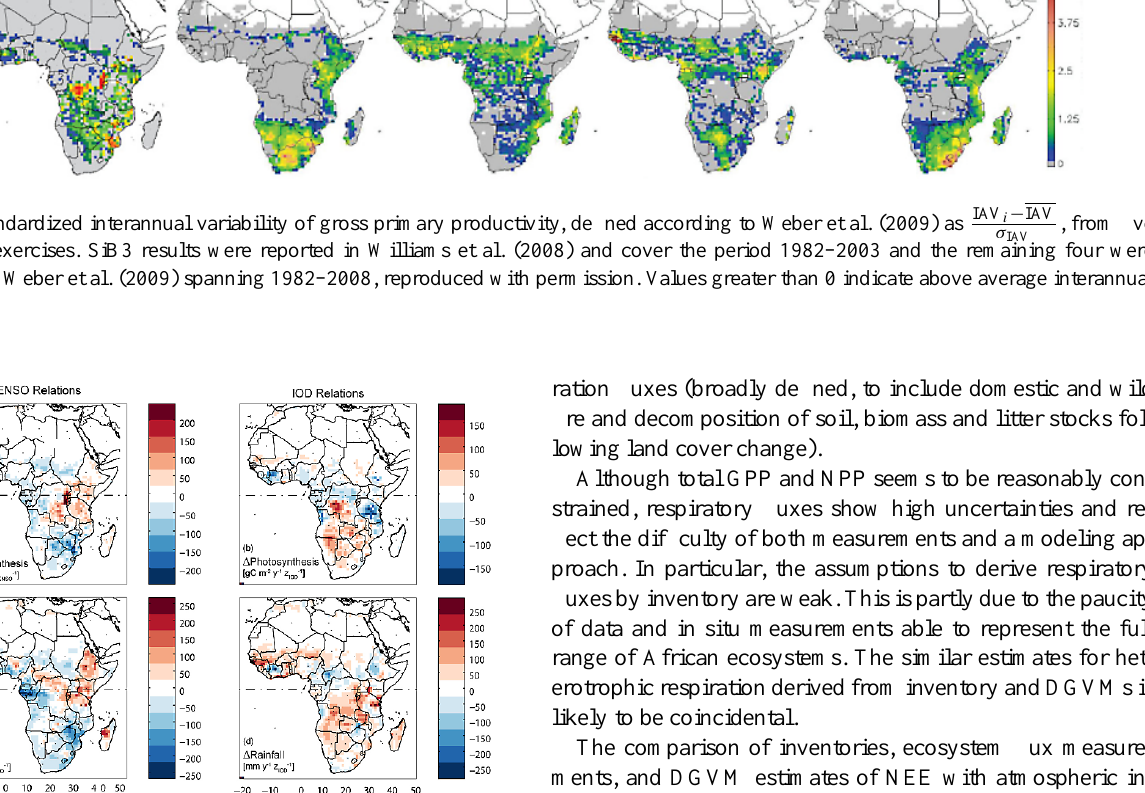
Fig. 7. Spatial distribution across Africa of the slope of least-squares linear regressions of SiB3 modeled (a, b) annual net photosynthe- sis ( P net ) or CRU/TRMM (c, d) annual rainfall on climate indices. Each column corresponds to analyses with a particular index with the left column (a, c) for the multivariate ENSO index, and the right column (b, d) for the Indian Ocean Dipole Mode Index (IOD). Re- sults are based on Williams et al.